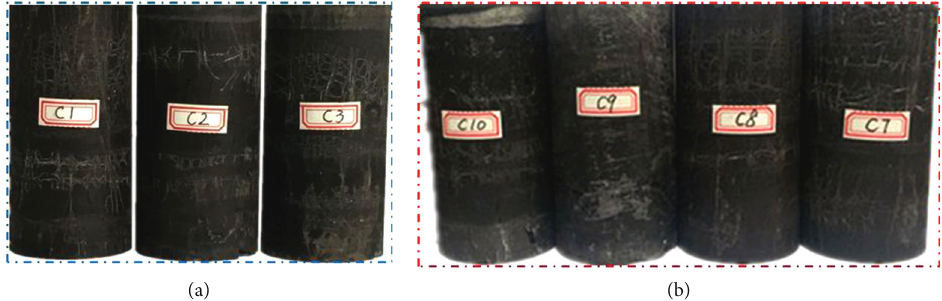
Figure 1: Photographs of coal samples: (a) uniaxial compressive tests; (b) cyclic loading